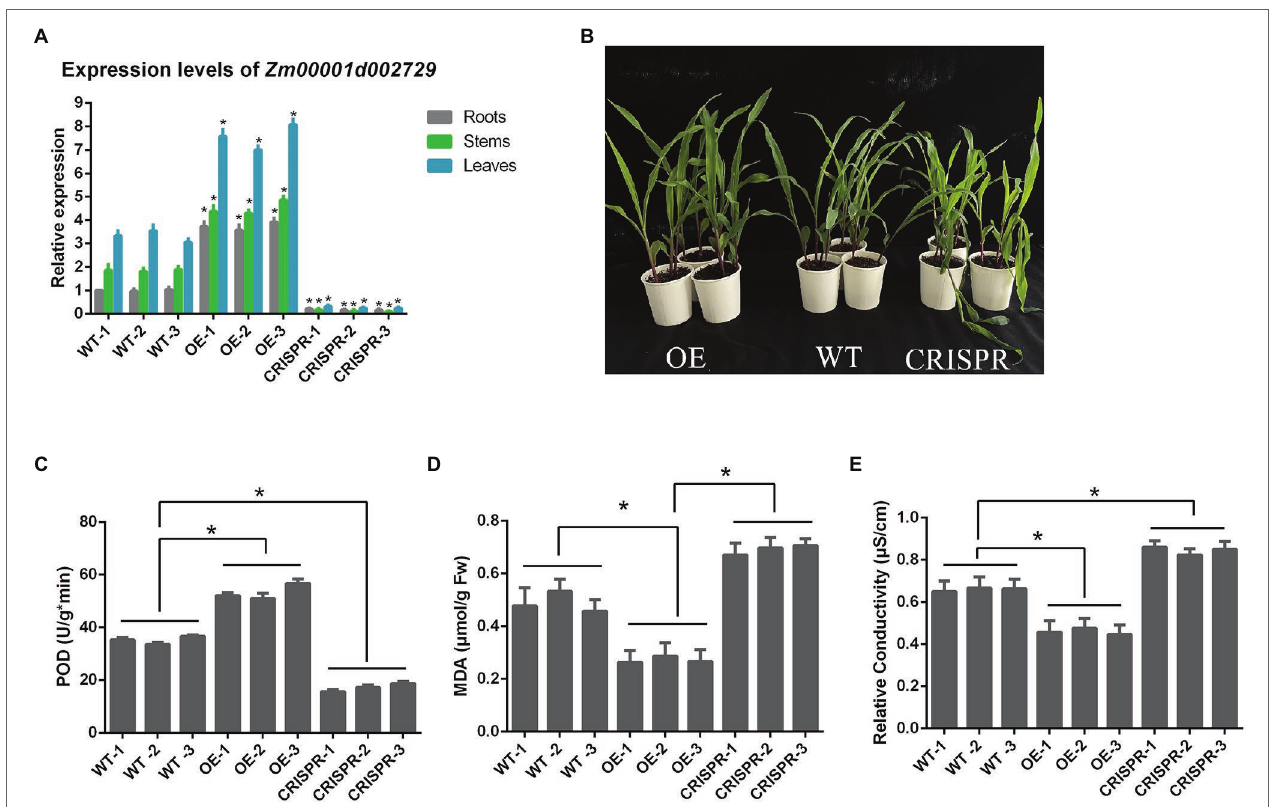
FIGURE 7 | (A) Relative expression levels of Zm00001d002729 in different maize tissues; (B) Comparison of maize morphology after exposure to 6 ° C cold stress for 24 h; (C) POD activity; (D) malondialdehyde (MDA) content; and (E) relative conductivity. * p <